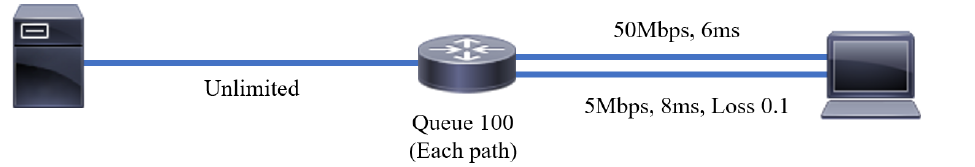
Figure 9. Network configuration with similar RTT paths and packet